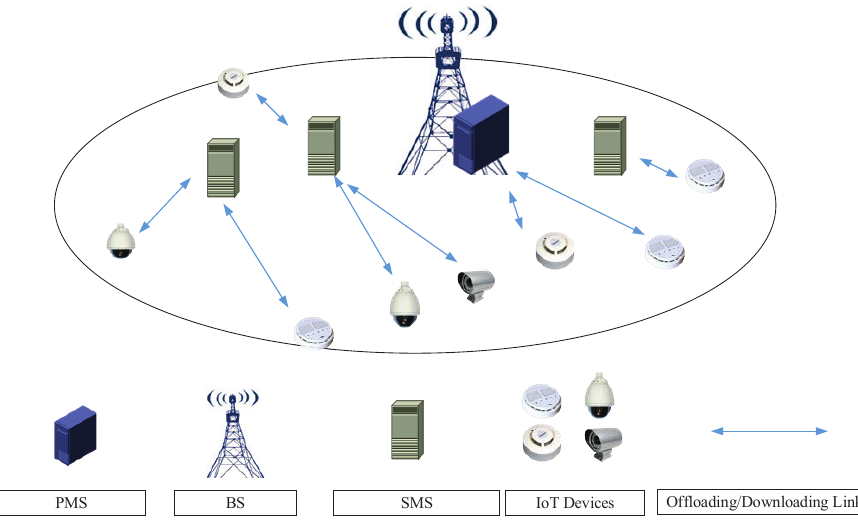
Figure 1. The illustration of the multi-MEC server cellular